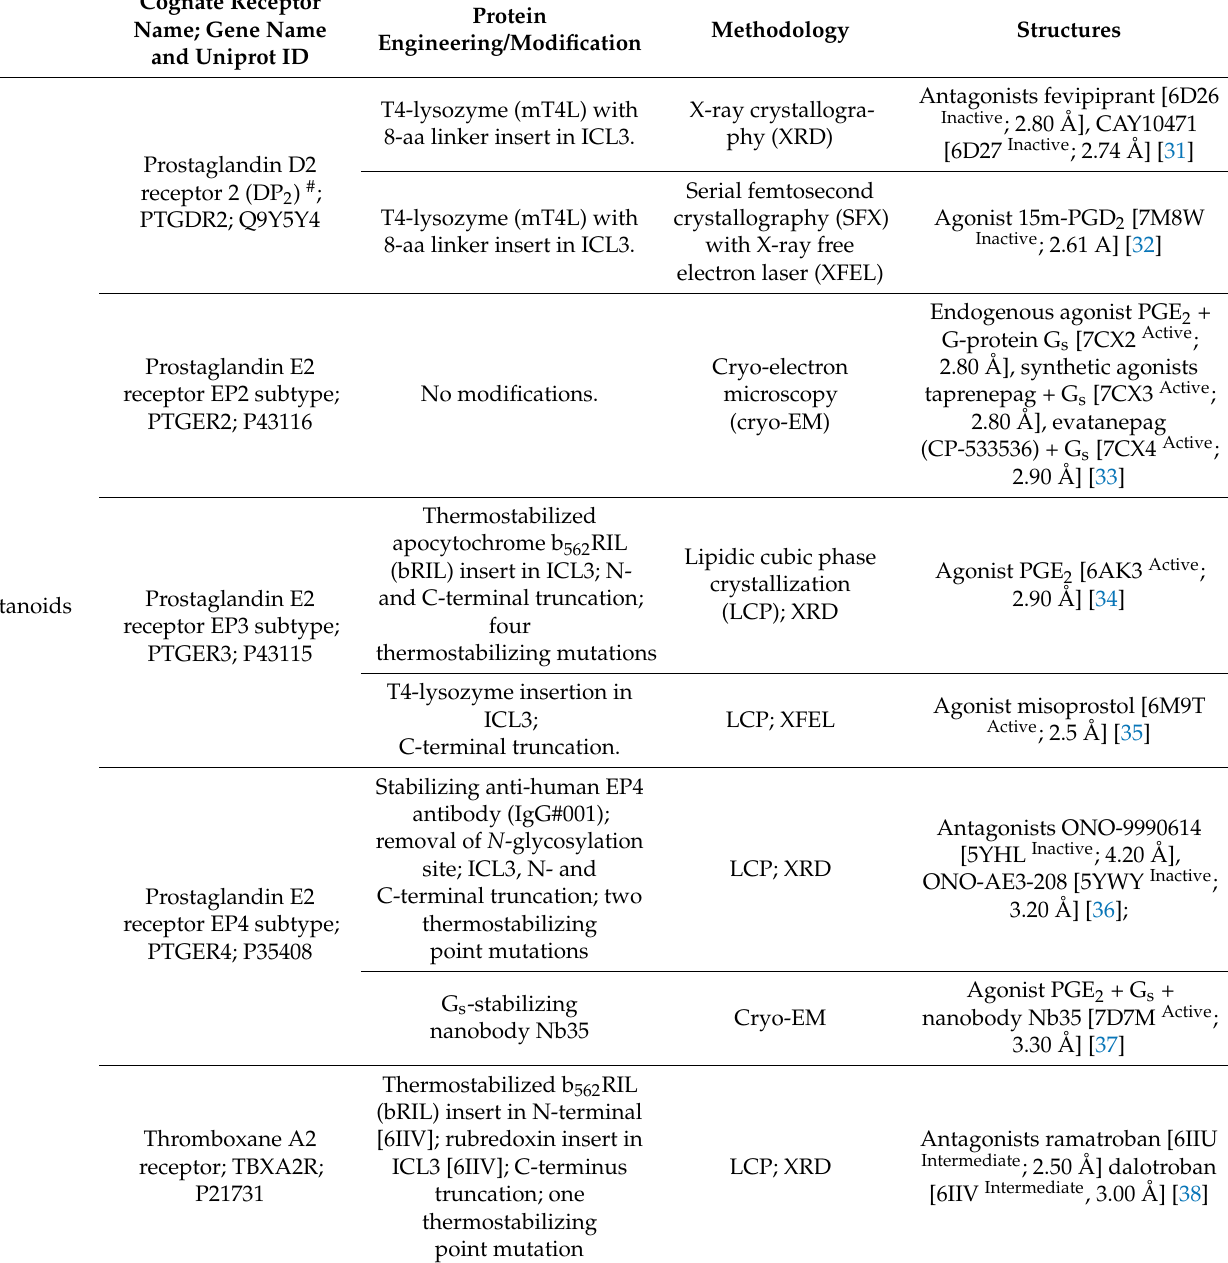
Table 1. Summary of all available experimentally determined structures of lipid GPCRs (as of September